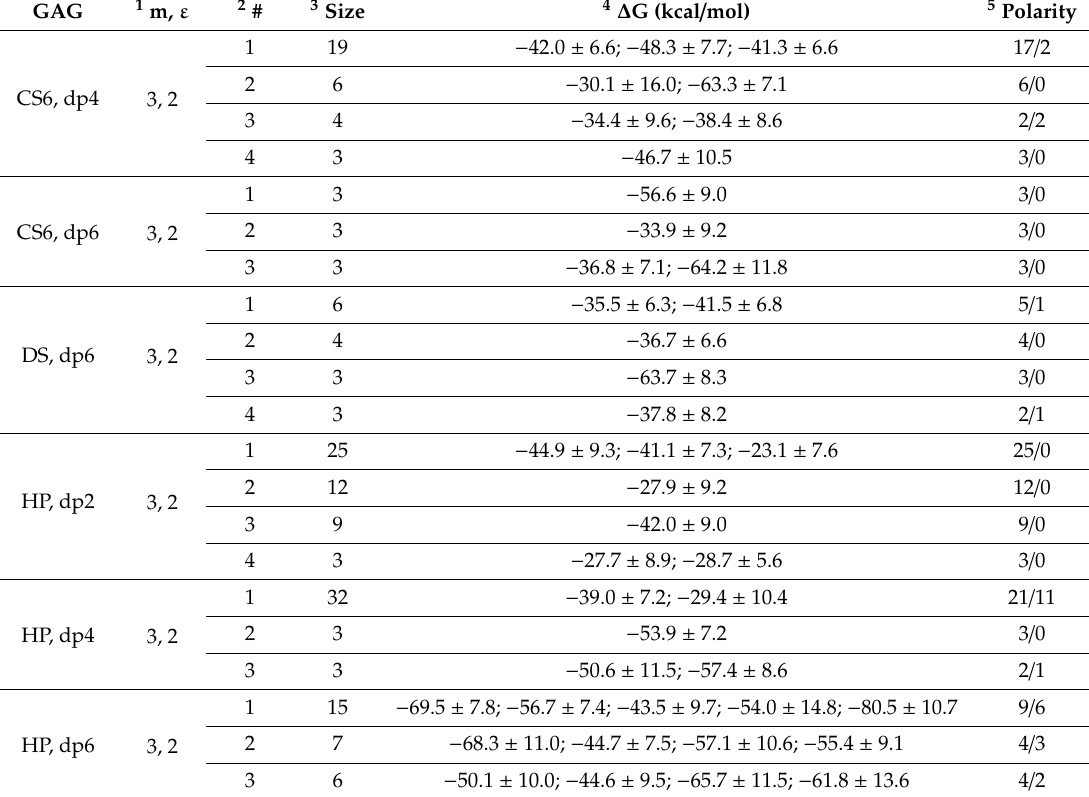
Table 2. Molecular docking molecular dynamics (MD)-based analysis summary for NTR-GAG